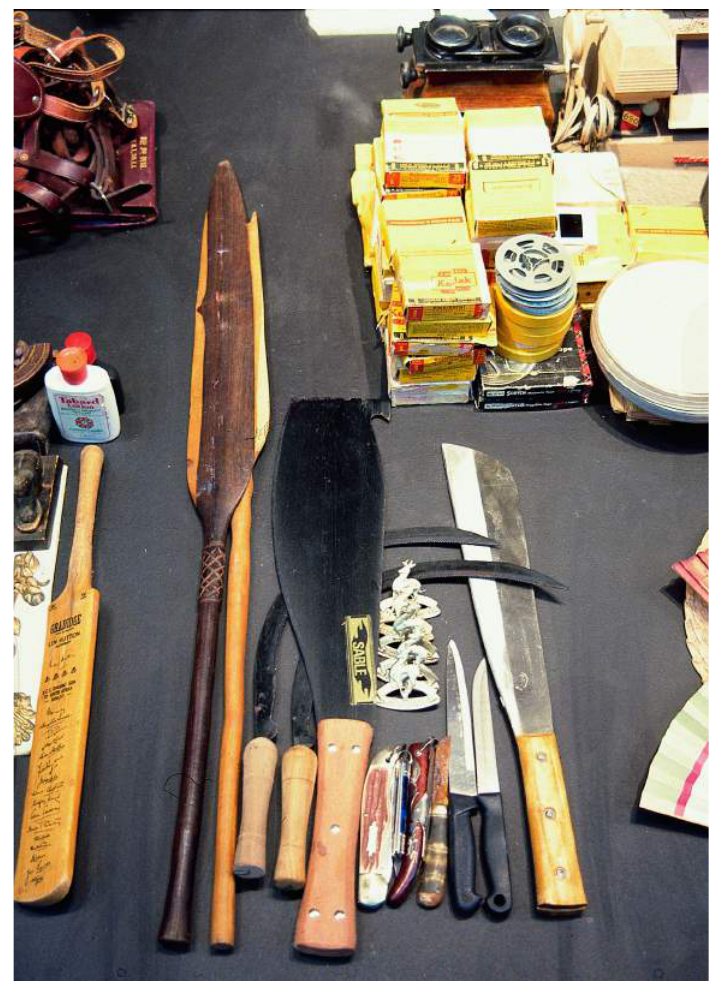
Penny Siopis, Reconnaissance (1900-1997) (detail), 1997. Installation of found objects, dimensions variable (photo: courtesy Penny Siopis and Stevenson Gallery, Cape